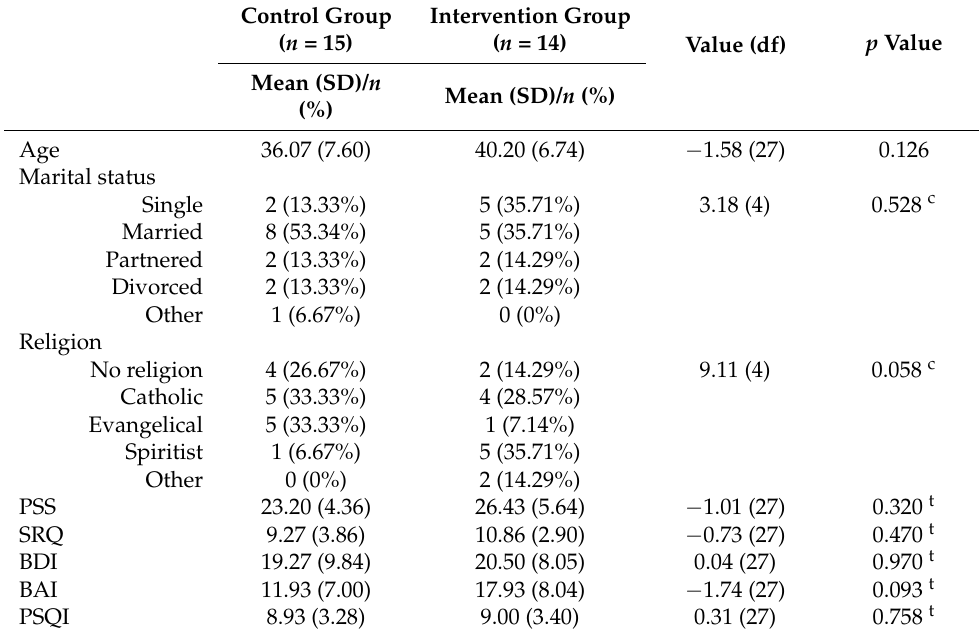
Table 1. Experiment 1: Demographic characteristics at baseline of intervention and control group.